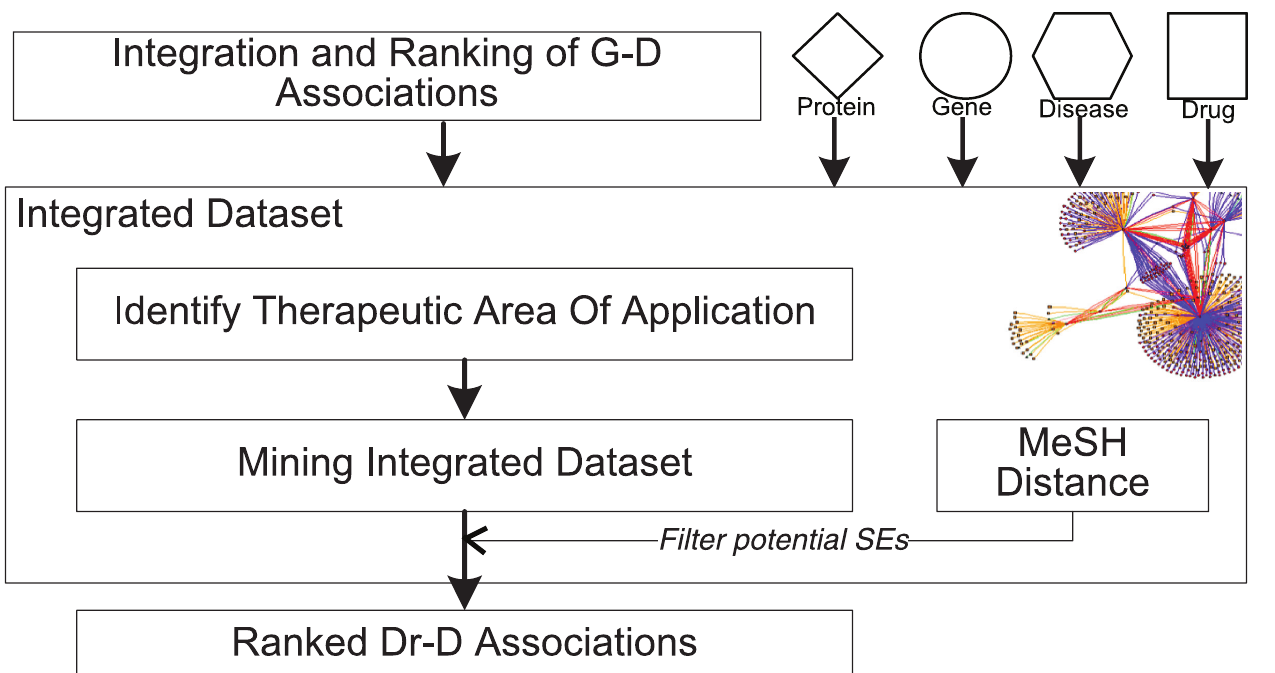
Fig 1. Overview of approach to identify novel drug-disease (Dr-D) associations. Gene-disease associations from 10 sources are first integrated and ranked. These scored associations are then integrated with protein, gene, disease and drug data to give an integrated dataset. A therapeutic area of application is then identified before the dataset is mined for instances of a semantic subgraph whose mappings contain inferred dd associations. Finally, any dd associations that are likely side effects (SEs) are filtered using the MeSH distance measure, before all ranked dd associations are